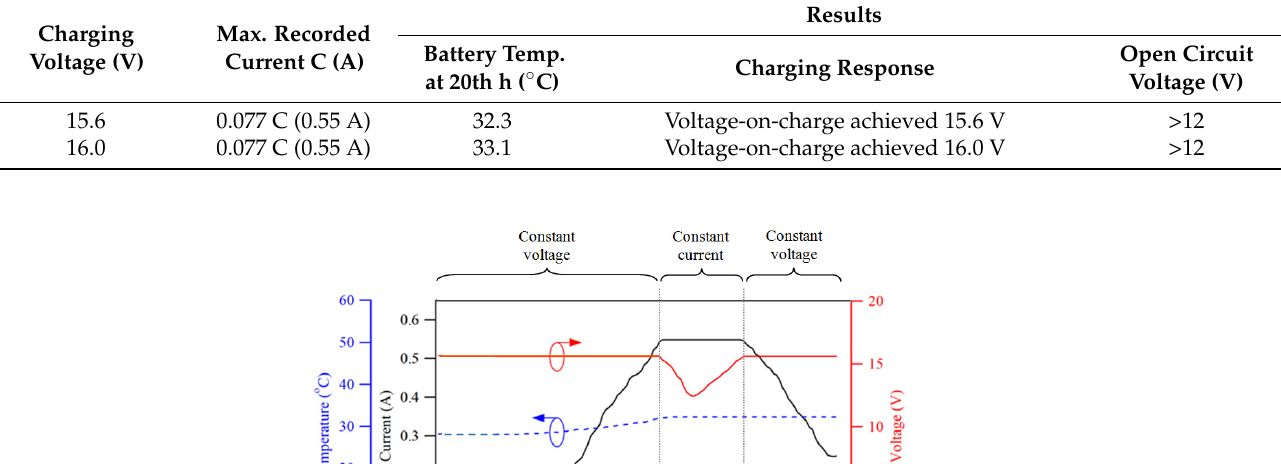
Table 5. Charging results for the recovered batteries charged at high charging voltages.